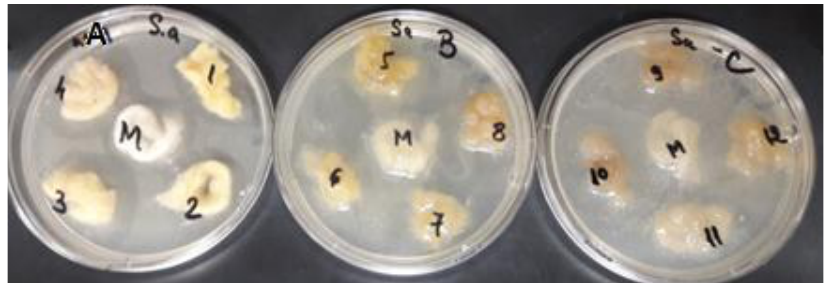
Figure 15. Antimicrobial activity of wool samples against Staphylococcus aureus ATCC 25923: A — wool samples treated with citric acid; B — UV-irradiated wool samples; C — untreated wool samples; 1 — wool dyed with aqueous extract, 2 — wool dyed with ultrasonic extract; 3 — wool dyed with alcohol extract; 4 — wool dyed with acid extract, M — control.